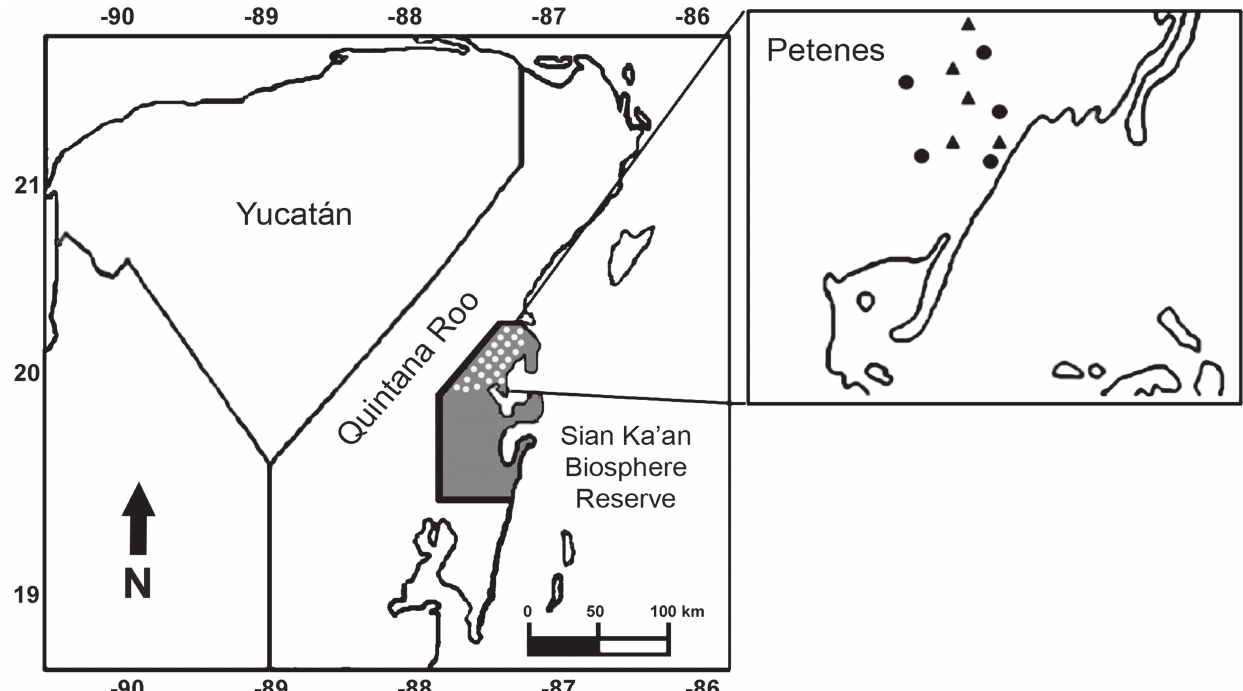
Fig. 1. Map of the study site in the Sian Ka’an wetland. Triangles = temporary pools; circles = permanent